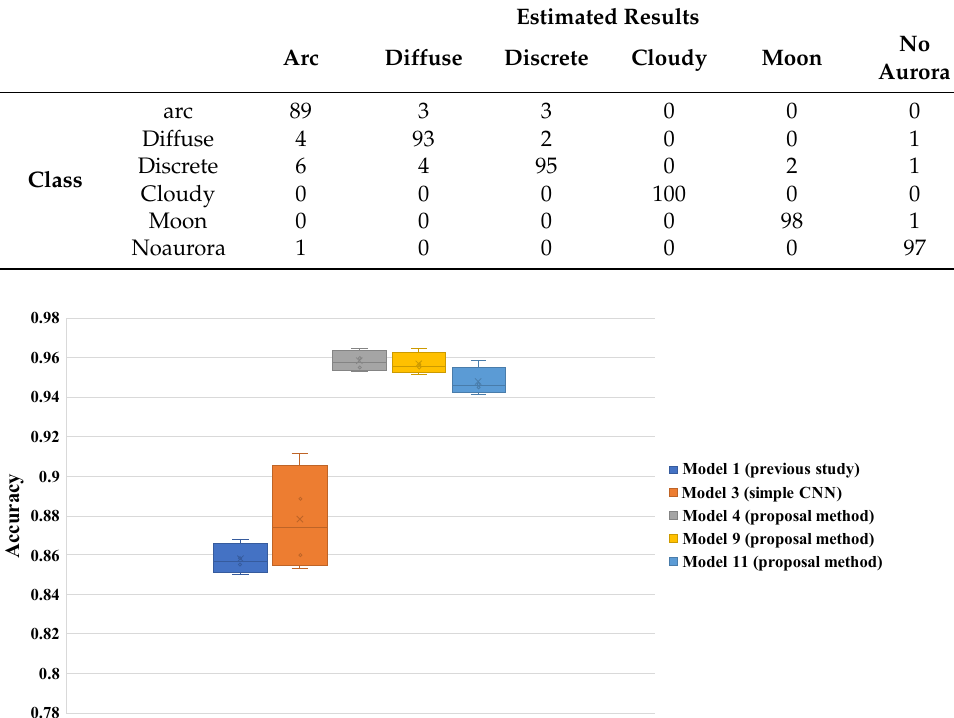
Table 5. Confusion matrices in the case of classification into six classes (Model 4).